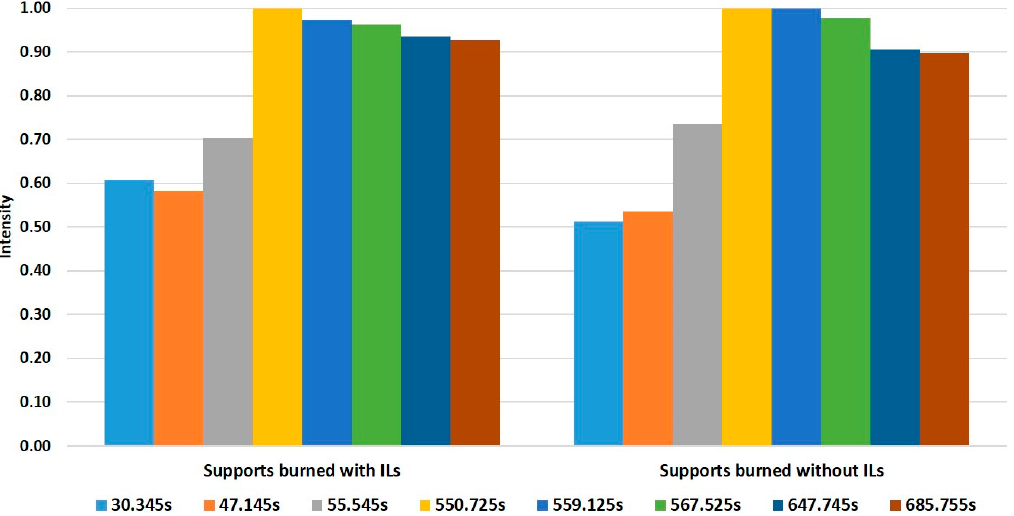
Figure 3. Fingerprints obtained from Fisher’s linear discriminant function for samples burned with or without ILs.